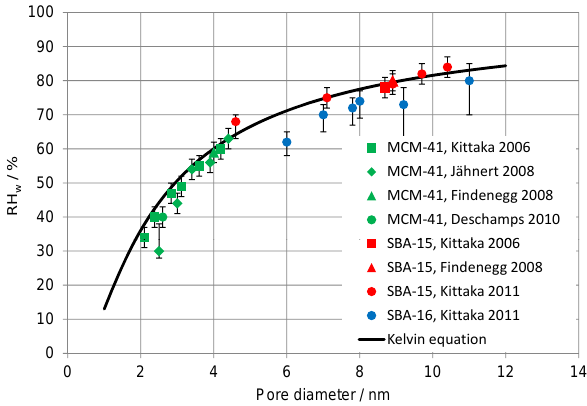
Fig. 1. Onset of capillary condensation of water in pores of dif- ferent mesoporous silica materials as a function of relative humid- ity RH w . Data is from Kittaka et al. (2006) (measured gravimetri- cally at 25 ◦ C), Jähnert et al. (2008) (DVS (dynamic vapor sorption) at 20 ◦ C), Findenegg et al. (2008) (measurements at 20 ◦ C), De- schamps et al. (2010) (DVS), and Kittaka et al. (2011) (measured gravimetrically). The black solid line indicates capillary condensa- tion predicted by the Kelvin equation (for T =